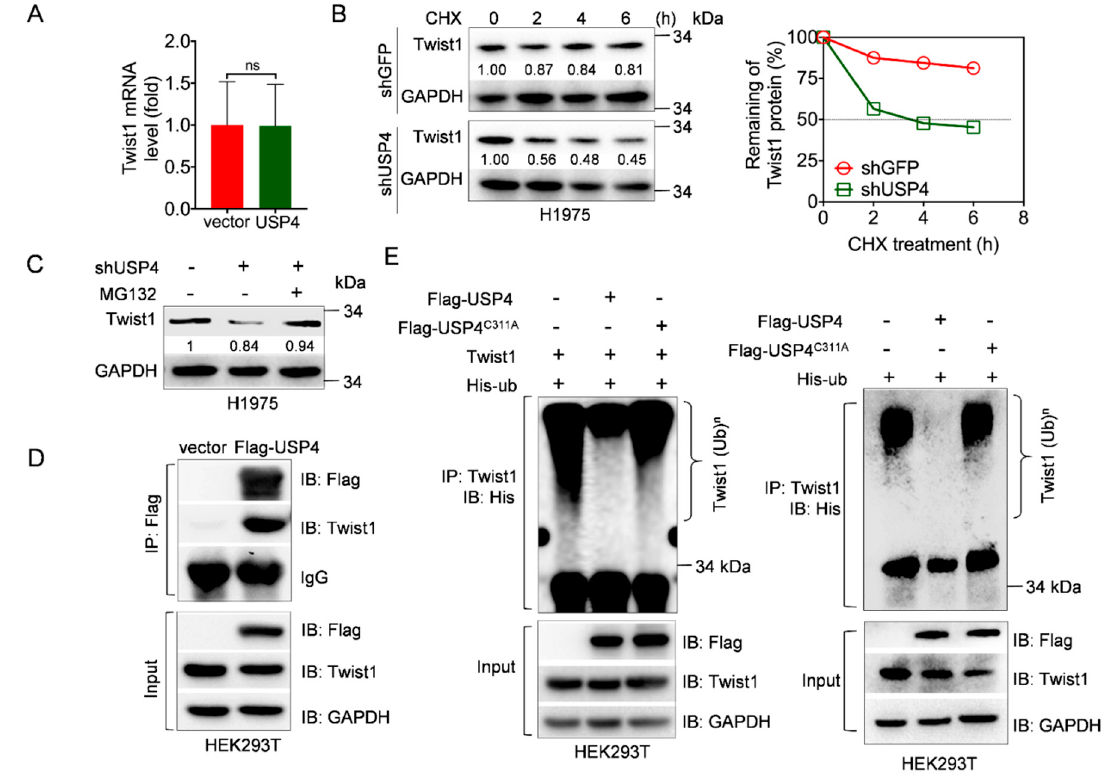
Figure 3. USP4 is a deubiquitinase of Twist1 protein. ( A ) H1975 cells stably expressing USP4 or a vector control were subjected to Q-PCR analyses. ns stands for no significance. ( B ) H1975 cells stably expressing shUSP4 or shGFP were treated with 50 µ g / mL cycloheximide (CHX) for an indicated time interval, and then subjected to Western blot analyses. Twist1 protein levels were quantified and the plot was presented. ( C ) H1975 cells stably expressing shRNAs against USP4 (shUSP4) were treated with or without 20 µ M MG132 for 12 h prior to Western blot analyses. ( D ) HEK293T cells were transfected with Flag-USP4 expressing plasmids for 36 h. Cells were treated with 20 µ M MG132 for 6 h prior to Co-IP experiments. ( E ) HEK293T cells were co-transfected with Twist1 and His-ubiquitin in the presence of either Flag-USP4 or Flag-USP4 C311A expressing plasmids for 36 h (left panel). HEK293T cells were co-transfected with His-ubiquitin and either Flag-USP4 or Flag-USP4 C311A expressing plasmids for 36 h (right panel). Cells were then treated with 20 µ M MG132 for 6 h prior to immunoprecipitation (IP) and Western blot